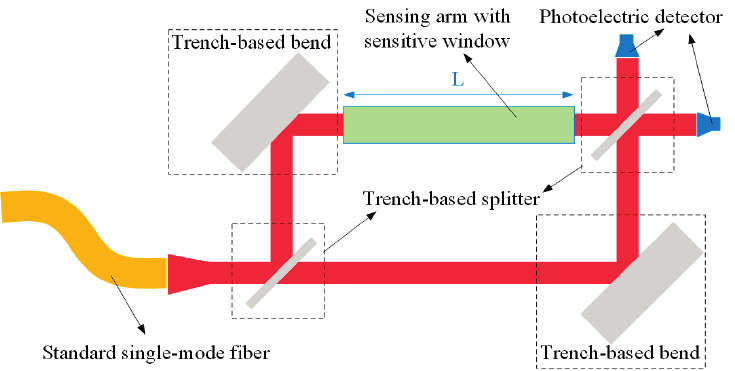
Figure 18. Schematic of the MZI sensing platform based on SOI rib waveguide with large cross